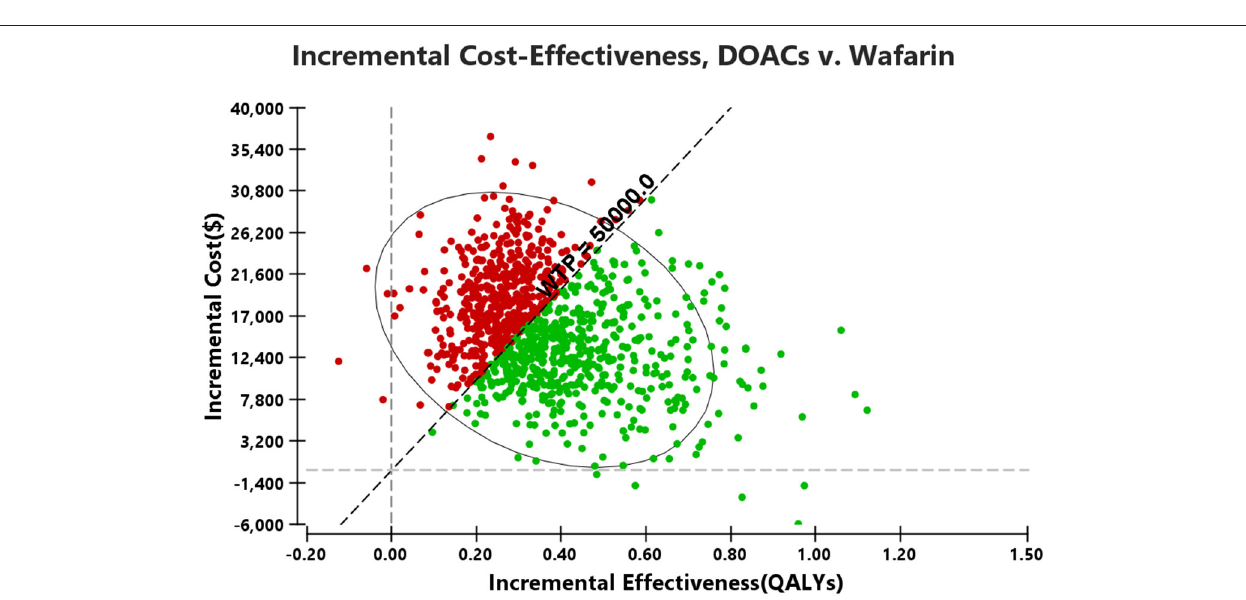
FIGURE 4 | Results of the probabilistic sensitivity